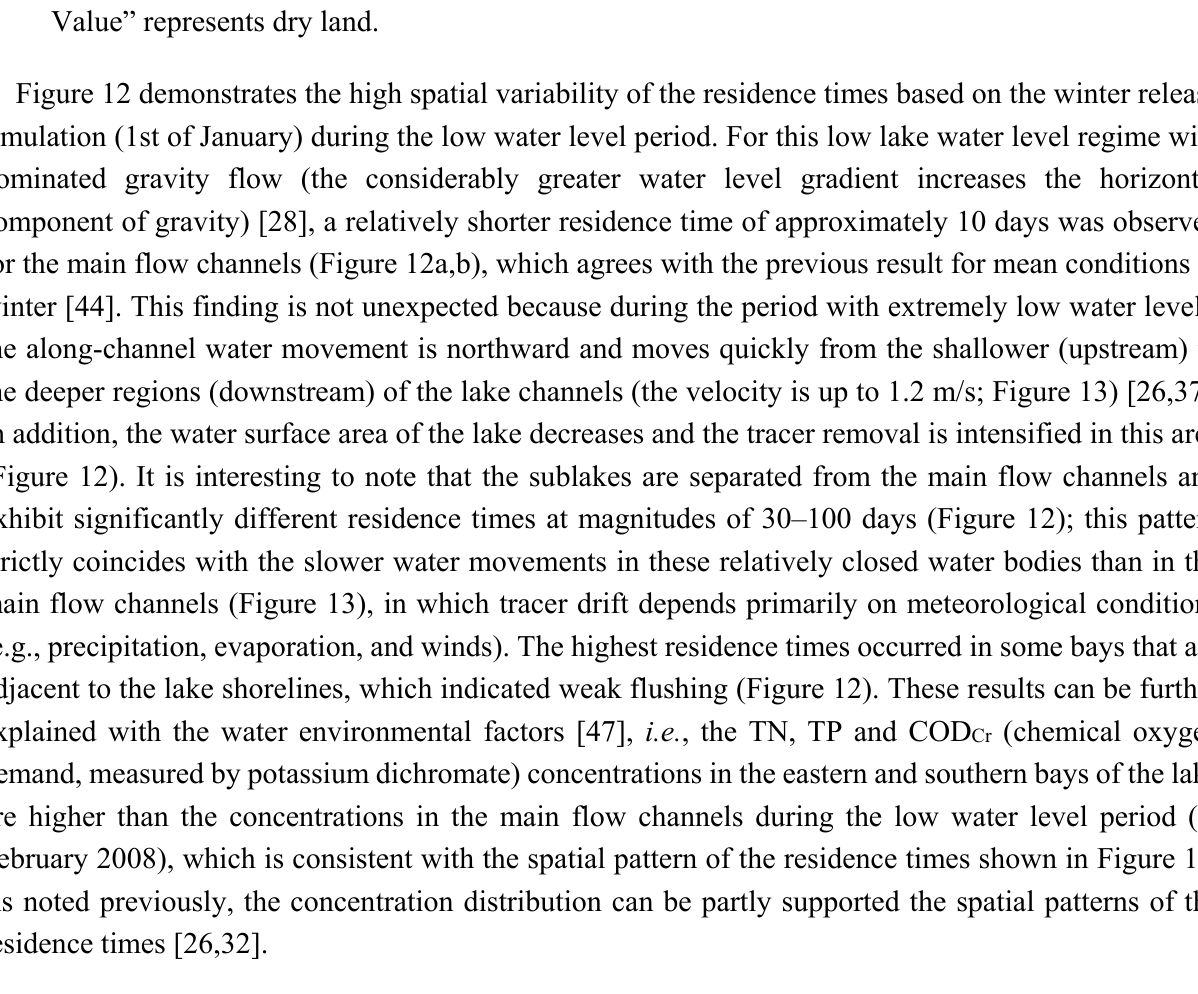
Figure 11. Map of the depth-averaged velocity (m/s) averaged over the water level recession period of MIKE 21 runs and a close-up of the velocity field for the region of interest. Red arrows represent the streamlines and associated flow directions. Note that the “Undefined Value” represents dry